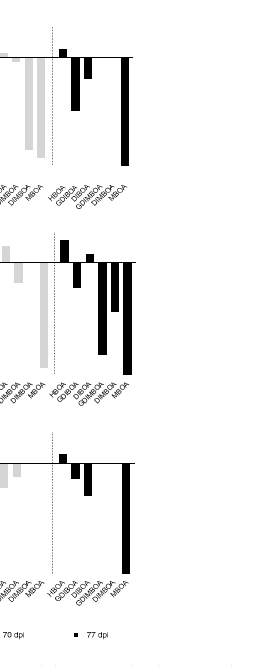
Figure 4. Benzoxazinoid (BX) concentrations in cold-treated plants relative to untreated plants of the rye inbred lines L318, D33, and D39 cultivated for 70 and 77 days. The results are presented as means of four biological replications.